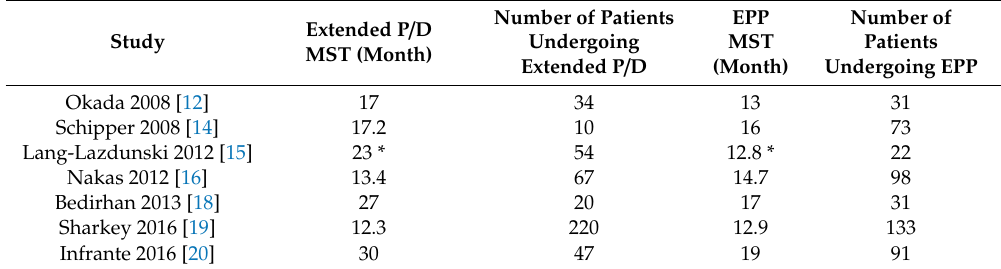
Figure 3. ( A ) Comparison of postoperative mortalities of Extended P / D and EPP. Forest plot of the odds ratio (OR) of the mortality after extended pleurectomy / decortication (P / D) vs. extrapleural pneumonectomy (EPP) in surgery for malignant pleural mesothelioma (MPM). ( B ) Comparison of postoperative morbidities of Extended P / D and EPP. Forest plot of the OR of the morbidity after extended P / D vs. EPP in surgery for MPM. The estimate of the OR of each study corresponds to the middle of the square, and the horizontal line shows the 95% confidence interval (CI). On each line, the event number as a fraction of the total number treated is shown for both treatment groups. For each subgroup, the sum of the statistics, along with the summary OR, is represented by a solid diamond. The results of a test of heterogeneity between the trials within a subgroup are given below the summary statistics. Table 2. A summary of the median survival time of extended pleurectomy / decortication (P / D) vs.